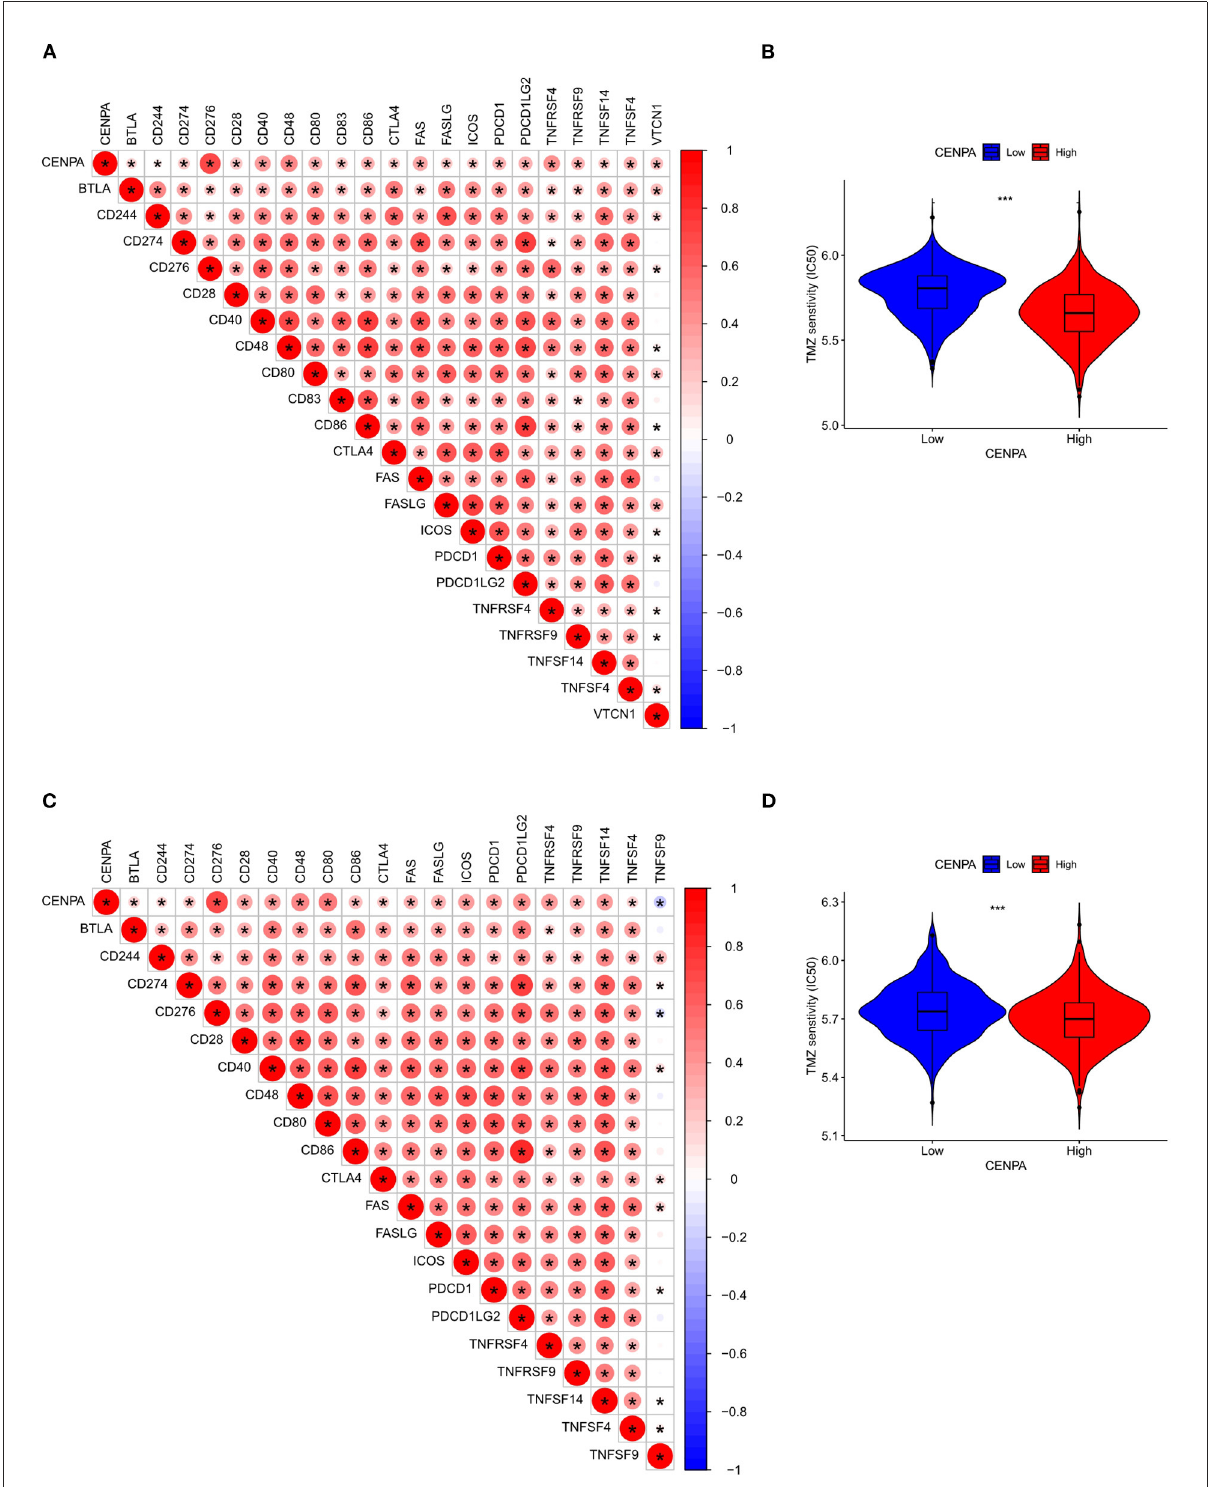
FIGURE8 Assessment of the correlation between CENPA and immune features in gliomas. CENPA significantly correlated with immune checkpoints in the CGGA database (A) and TCGA database (C) . Sensitivity of temozolomide significantly differs between the low- and high-CENPA-expression group using the CGGA database (B) and TCGA database (D) (Wilcoxon test, * P < 0.05, ** P < 0.01, *** P < 0.001). The Pearson coefficient was used for the correlation